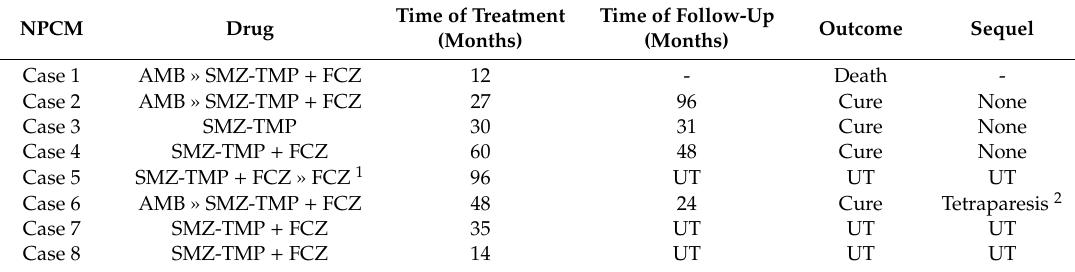
Table 3. Therapeutic and outcome data of the NPCM cases from this